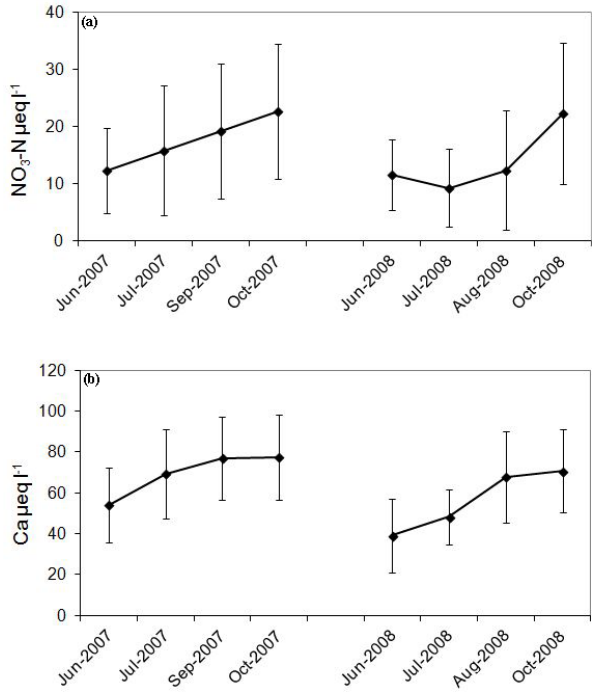
Fig. 3. Mean and standard deviation of NO 3 (a) and Ca (b) concen- trations measured in the running waters during the study period.